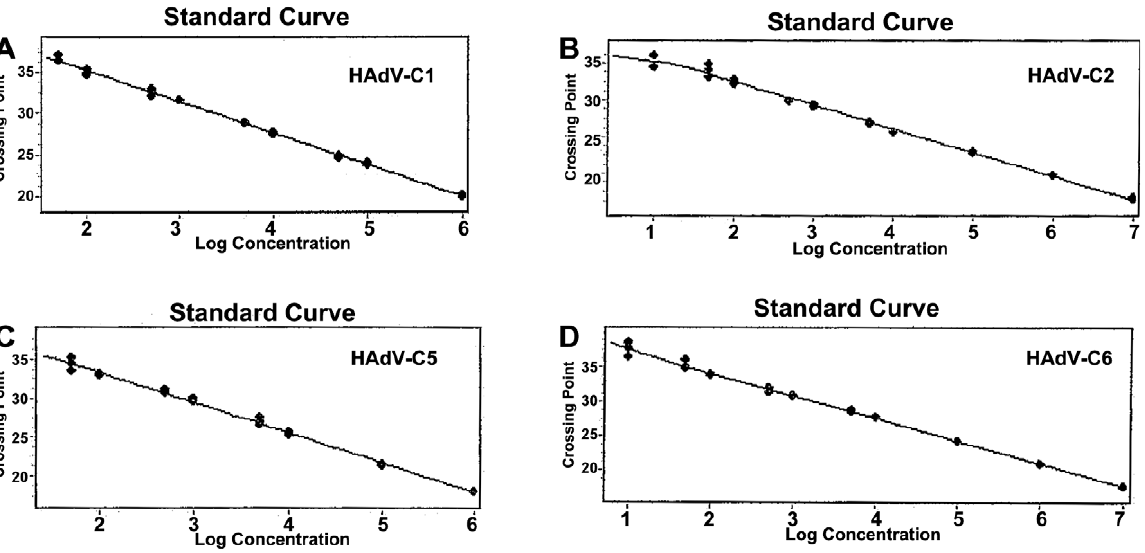
Figure 1. Standard curves for amplification of HAdV-C1, -C2, -C5, and -C6. Detection by real-time LightCycler PCR in a series of dilutions of genomic HAdV-C1, -C2, -C5, and -C6 DNA. Linear regression of the standard curves for (A) HAdV- C1, (B) HAdV-C2, (C) HAdV-C5, and (D) HAdV-C6. We defined the LLOD as the last dilution before the crossing points ceased to increase. doi:10.1371/journal.pone.0026862.g001 PLoS ONE |